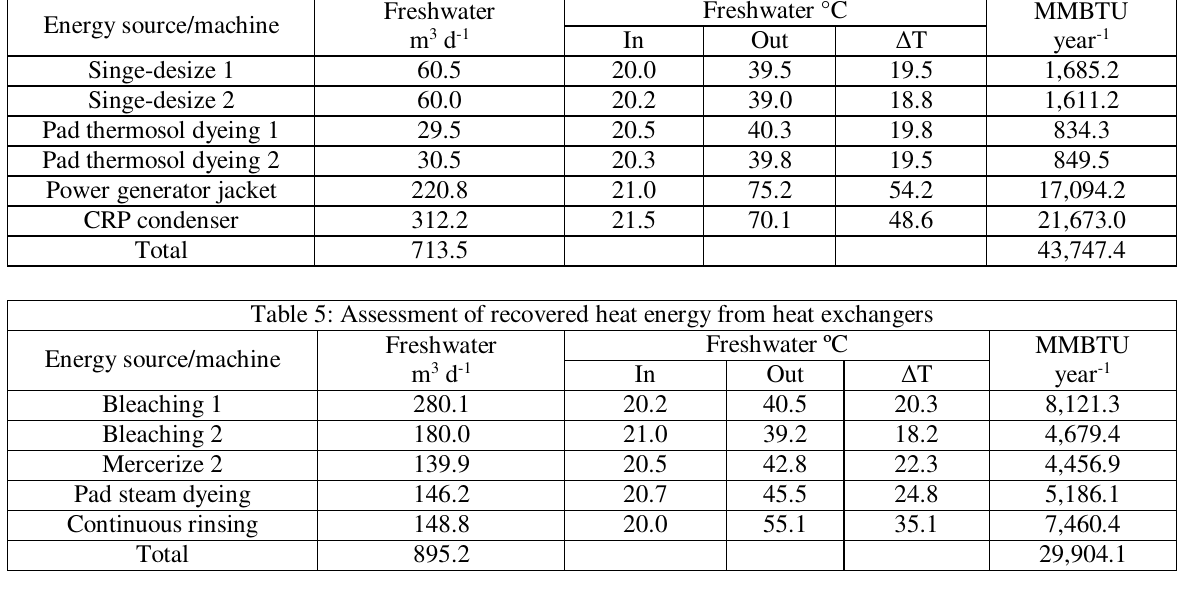
Table 4: Assessment of recovered heat energy from cooling water Energy source/machine